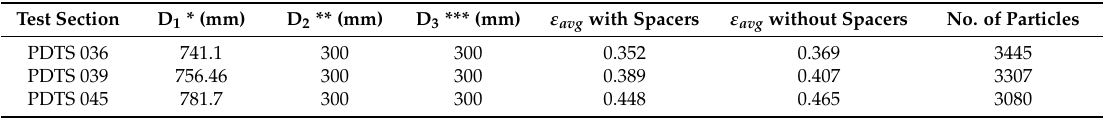
Table 7. Pressure drop test section (PDTS)